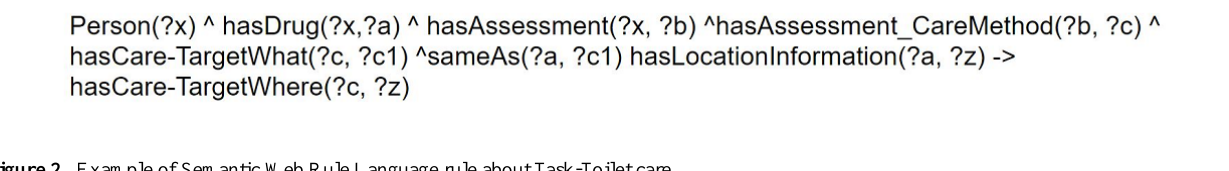
Figure 1. Example of Semantic Web Rule Language rule about location notification.